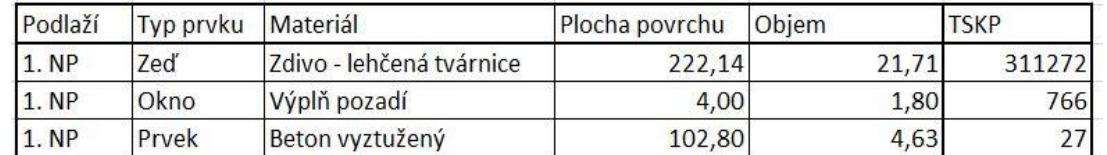
Tabulka 1: Optimální výstup z modelu BIM